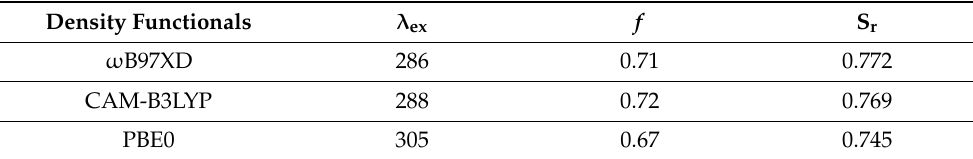
Table 2. Excitation wavelength (λ ex , in nm), oscillator strength ( f ), and S r index for the S 0 → S 1 excitation of Br-Clmd-2 in implicit water, when calculated at the TD-DFT level of theory with different functionals.